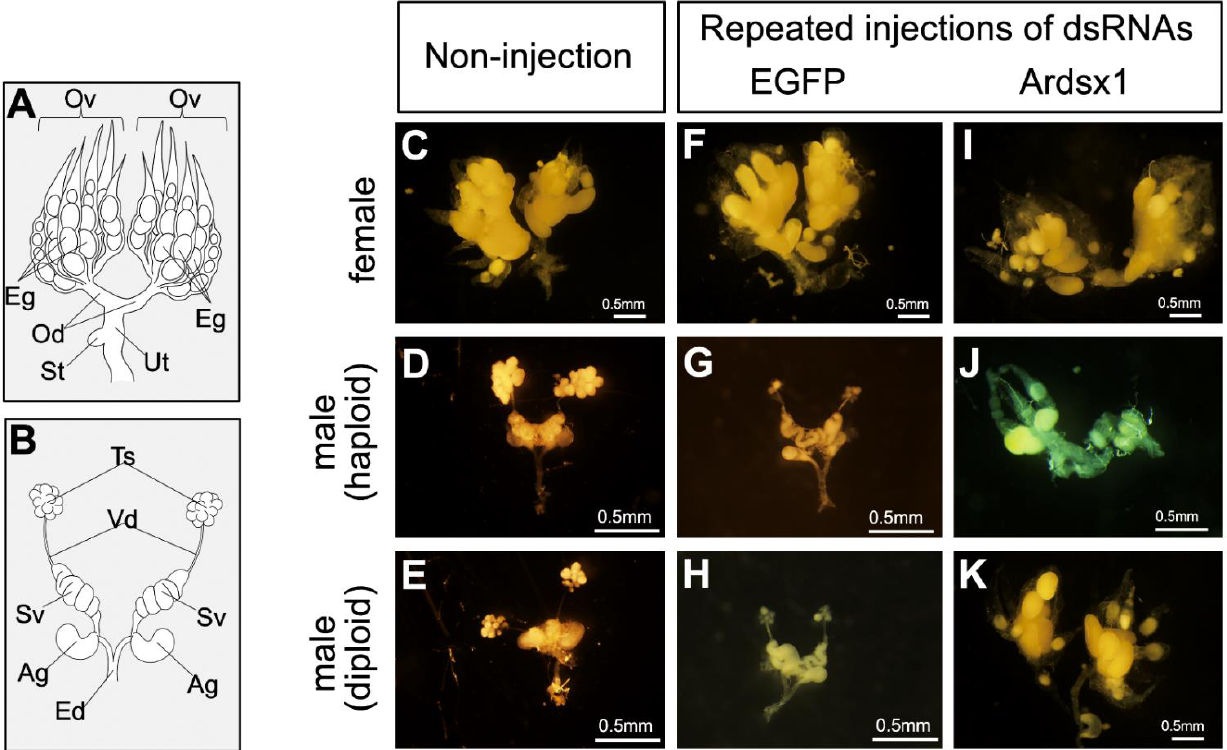
Figure 3. Effects of RNAi-mediated knockdown of Ardsx on sexual development of internal genital organs and oogenesis. ( A , B ) Schematic diagrams of female ( A ) and male ( B ) internal reproductive organs. Eg, egg; Ov, ovary; Od, oviduct; St, spermatheca; Ut, uterus; Ag, accessory gland; Ed, ejaculatory duct; Sv, seminal vesicle; Ts, testis; Vd, vas deferens. ( C – K ) Ventral view of the internal genitalia at the adult stage. Female ( C ), haploid male, and diploid male ( E ) without injection of dsRNA. Negative control female ( F ), haploid male ( G ), and diploid male ( H ) obtained via repeated injections of EGFP dsRNA. Ardsx -knockdown female ( I ), haploid male ( J ), and diploid male ( K ) obtained via repeated injections of Ardsx1 dsRNA. Table 1. Number of injected animals, adults subjected to the analysis, and adults that exhibited sex-reversal phenotype.